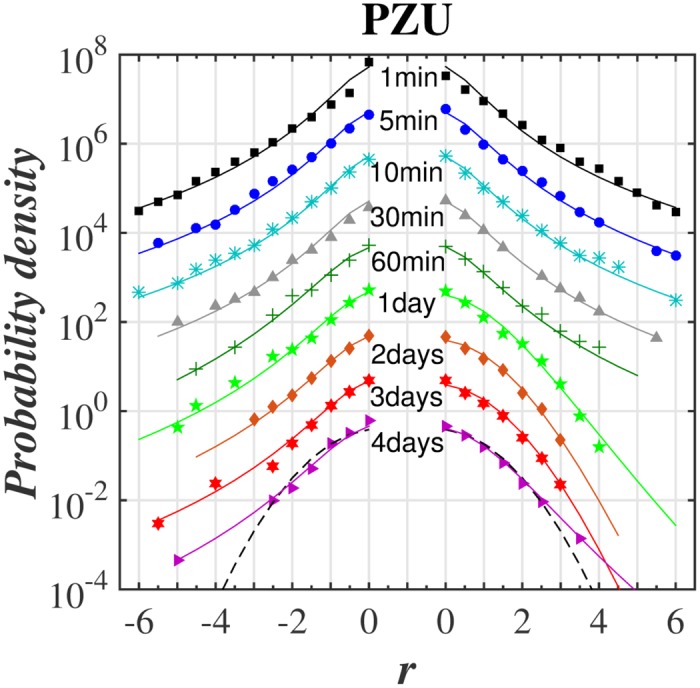
Same as in Fig 1 for PZU stock.